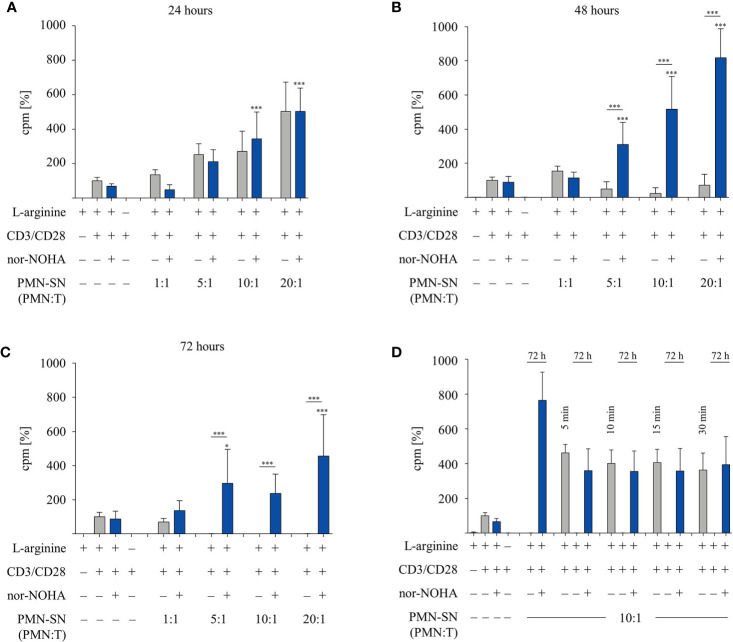
A pronounced T cell immunostimulatory effect is detected very early in polymorphonuclear neutrophil granulocytes supernatants (PMN-SN), while arginase-mediated inhibition of T cell proliferation needs much longer PMN-SN incubation time. Human T cells and PMN were isolated from whole blood of healthy donors. PMN were incubated in cell culture medium for (A) 24 h, (B) 48 h, or (C) 72 h in the presence or absence of the arginase inhibitor nor-NOHA (1 mM; n=4 experiments). (D) PMN were incubated in cell culture medium for only 5 min, 10 min, 15 min, or 30 min. Supernatants from these short incubations were collected and PMN were incubated for another 72 h in fresh medium in the presence or absence of nor-NOHA (1 mM; n=3). (A–D) T cells were stimulated with anti-CD3/anti-CD28-tagged beads and cultured in PMN-SN for 48 h. T cell proliferation was determined by [3H]thymidine incorporation over 16 h and values of control stimulated cells in the presence of arginine were set as 100%. Unless otherwise stated, statistical analysis refers to the control conditions of activated T cells in the presence of L-arginine and nor-NOHA. Statistical calculations were performed with one-way ANOVA and Tukey´s post hoc test (***p < 0.001, *p < 0.05).